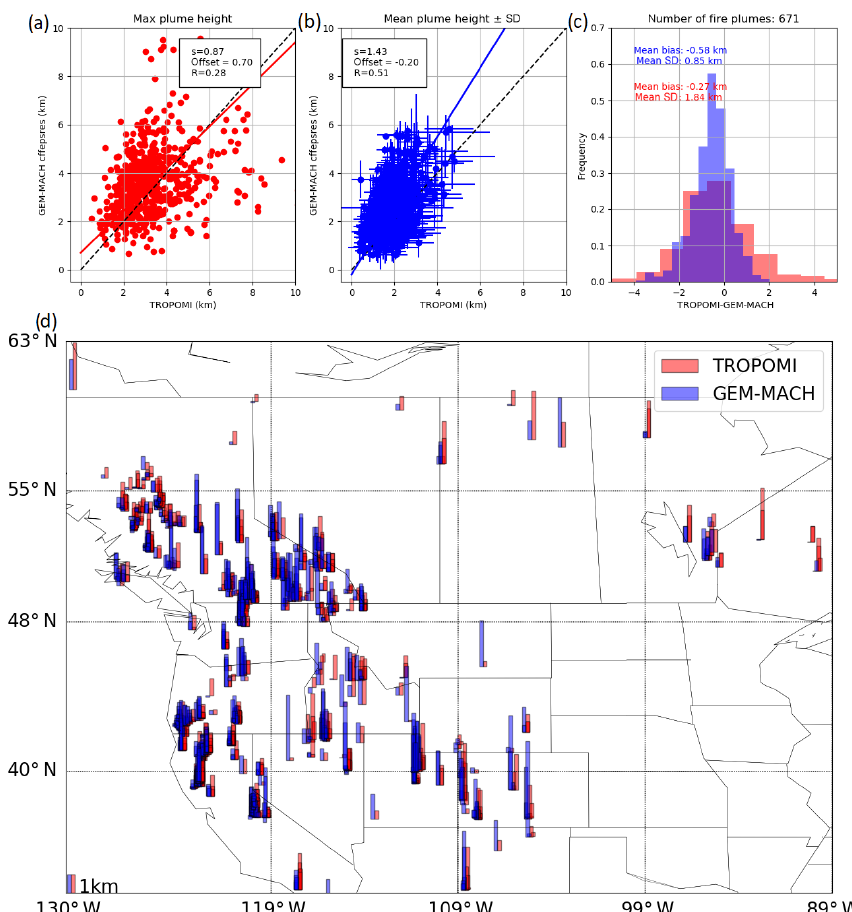
Figure 6. Same as Fig. 5 but for the TROPOMI–model